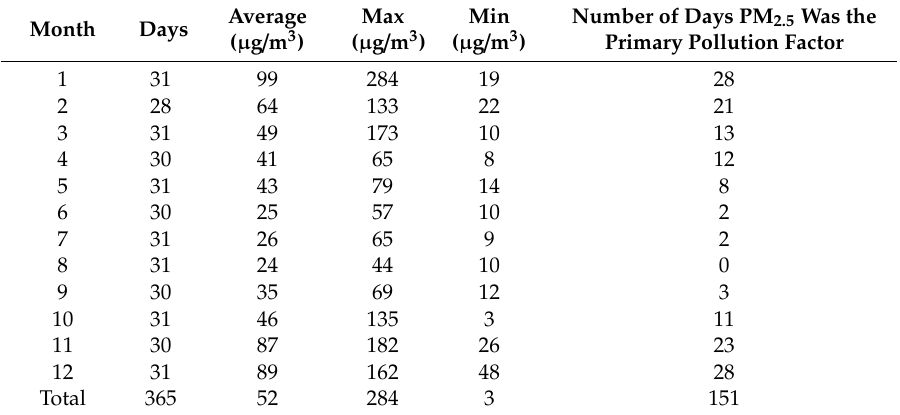
Table 1. Monthly PM 2.5 concentration data statistics in